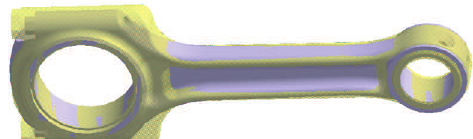
Fig. 13. Geometric changes between model 4 (yellow) and model 5 (grey)